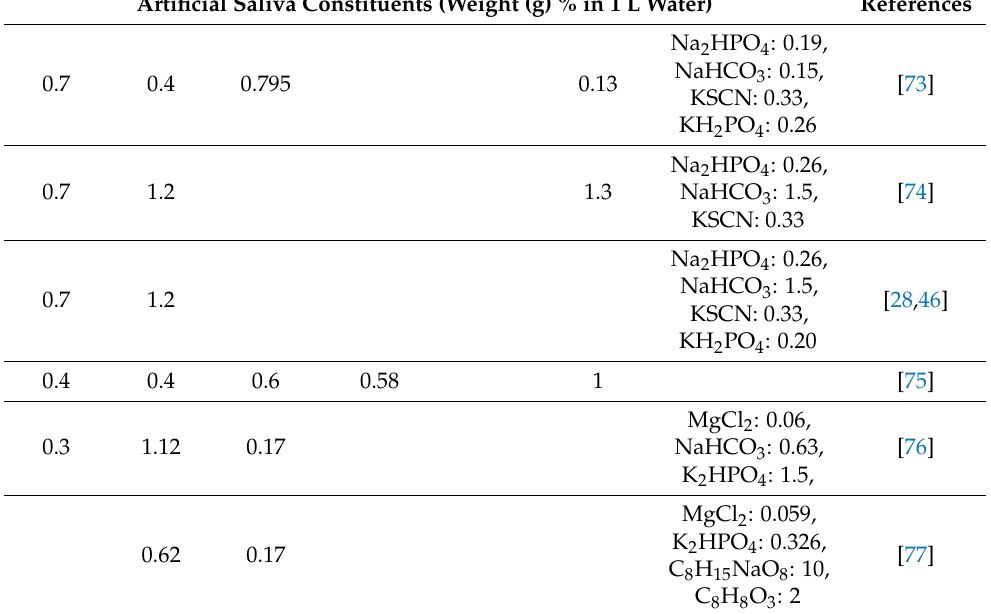
Table 1. Cont. Artificial Saliva Constituents (Weight (g) % in 1 L